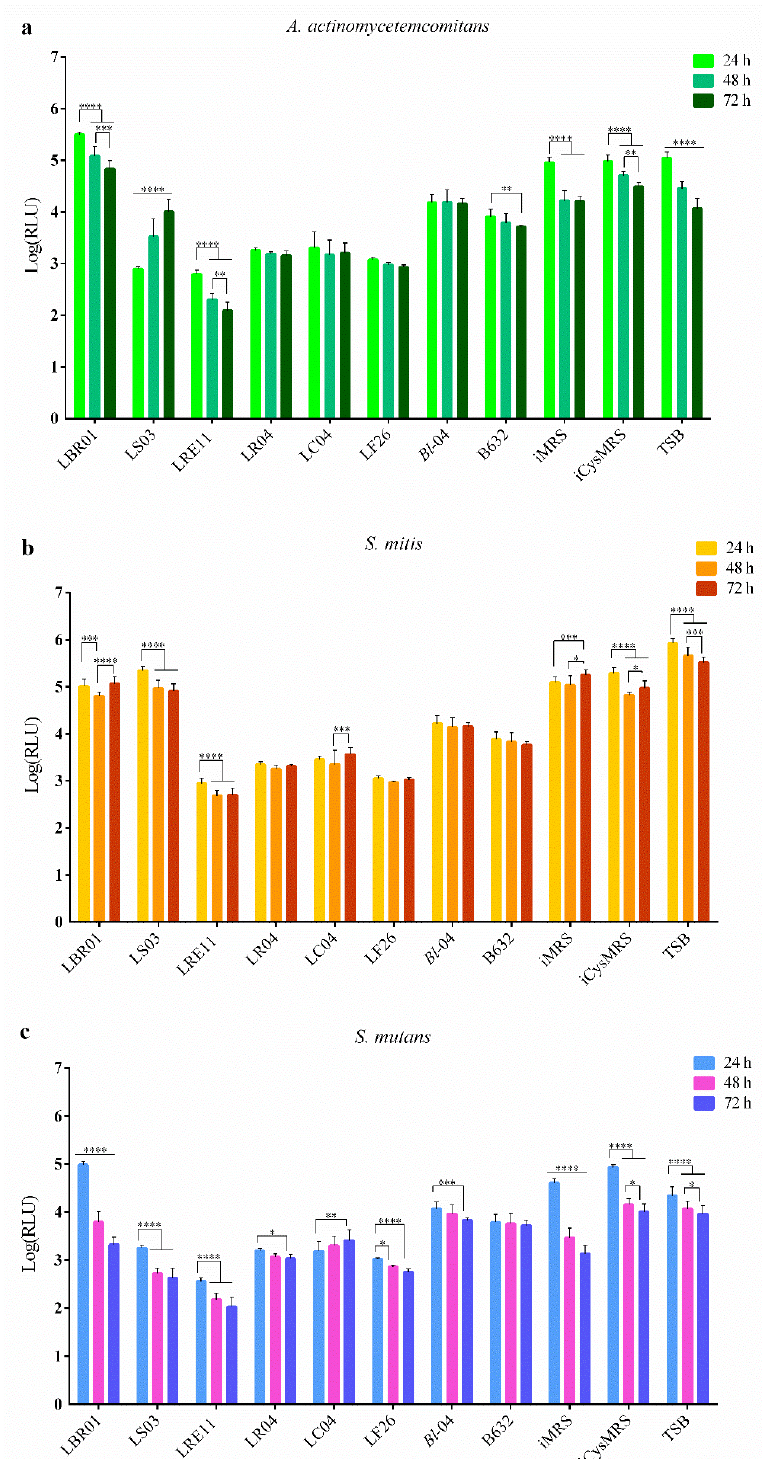
Figure 2. Viability assay. ( a ) A. actinomycetemcomitans , ( b ) S. mitis , and ( c ) S. mutans viability was determined after 24, 48, and 72 h of probiotic CFS treatment. Data are represented as the Log(mean) of three independent experiments ± SD. * p < 0.05; ** p < 0.01; *** p < 0.001; **** p < 0.0001. Log(RLU) = Logarithm10 (relative luminescence unit); CFS = cell-free supernatant. To summarize, LBR01 CFS was the one showing the lowest activity against the single pathogens, followed by LS03 CFS, which significantly reduced only S. mutans